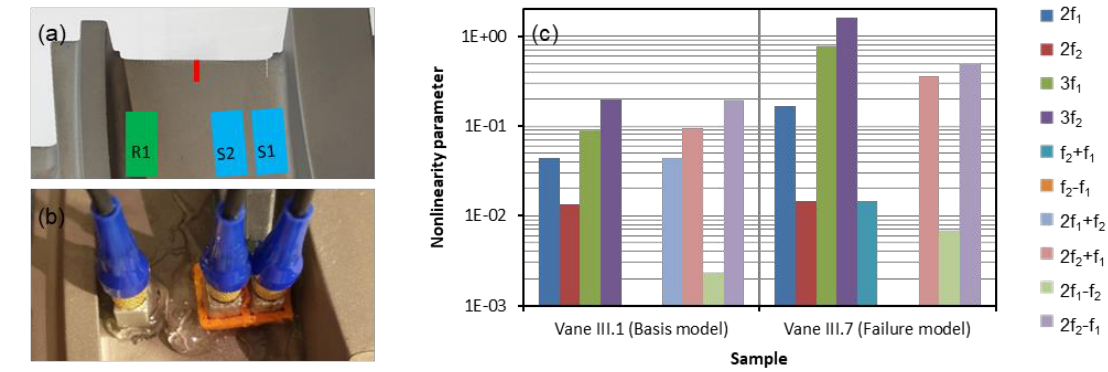
Figure 29. Nonlinearity parameter, parallel sensor orientation, f 1 = 4 MHz, f 2 = 5 MHz: ( a ) Sensor orientation; ( b ) Experimental setup; ( c ) Comparison of nonlinearity parameter.